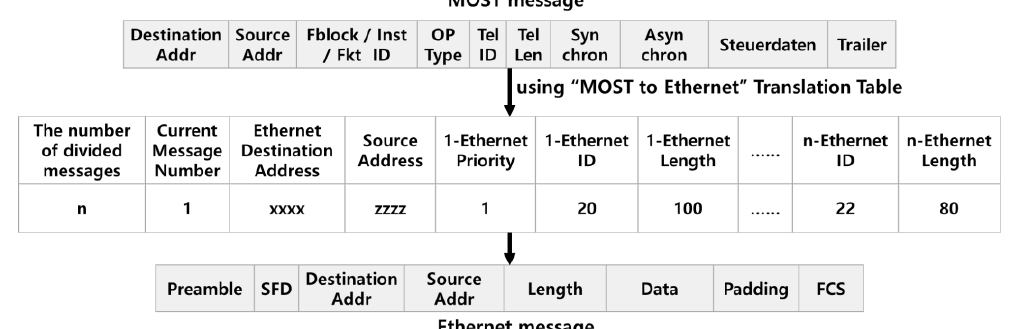
Figure 9. The Transformation of MOST into Ethernet message by Mapping.